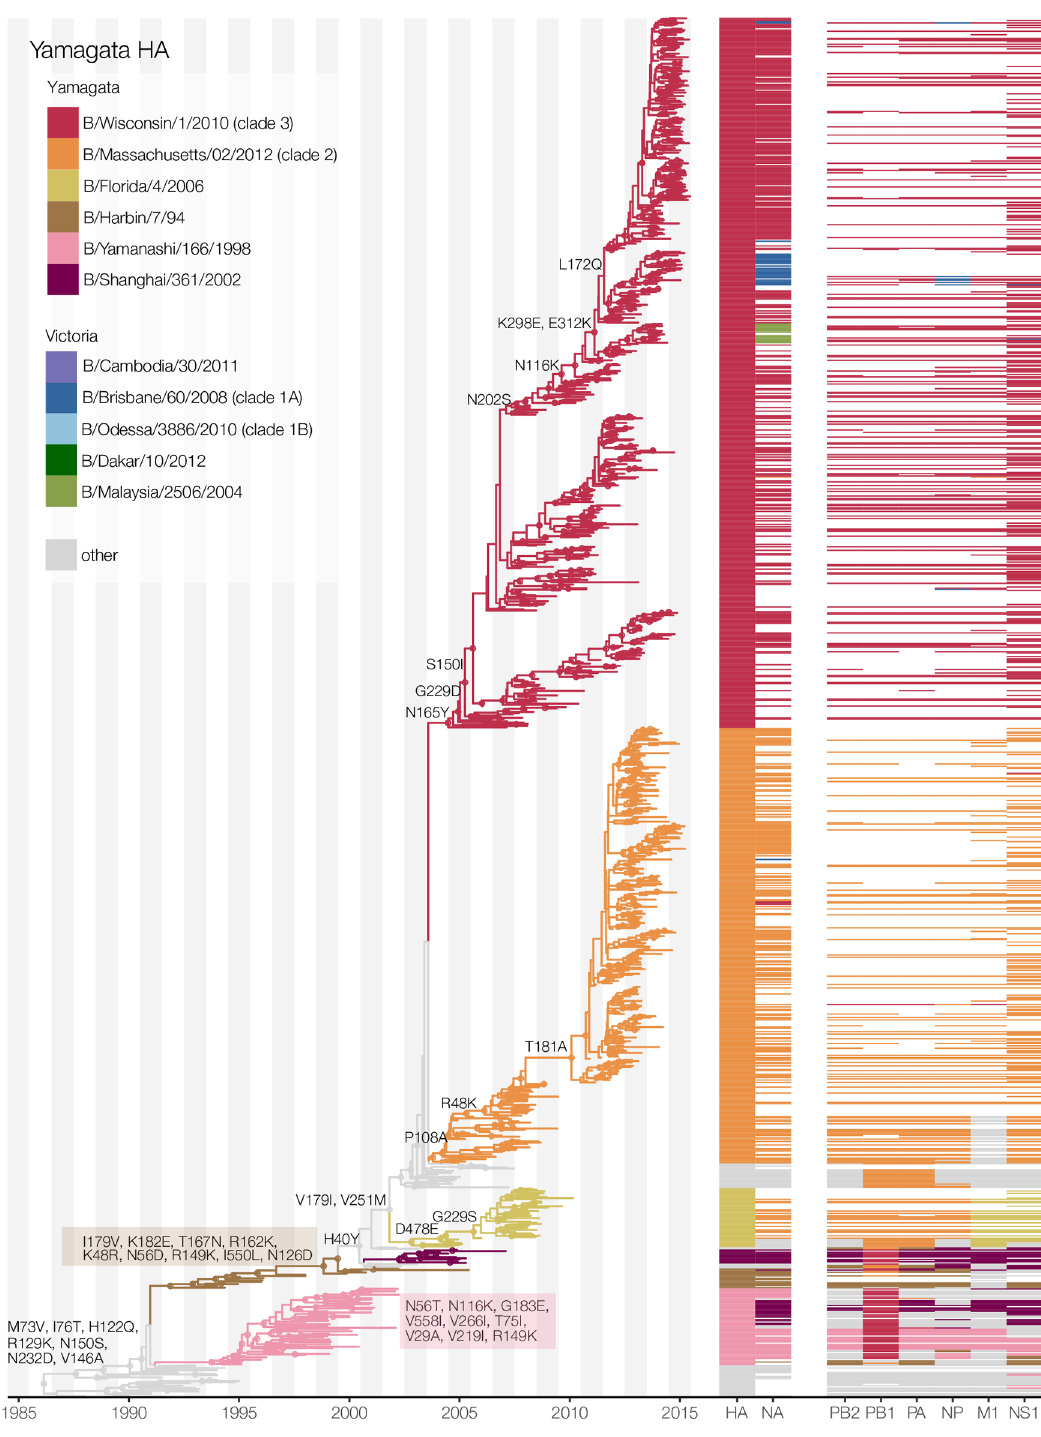
Fig 2. Maximum clade credibility tree inferred from 1,169 Yamagata-lineage HA gene sequences and corresponding genotype constellations. Branches of the phylogeny are labeled with amino acid substitutions occurring along the phylogenetic ‘trunk’ and colored by well-supported clade distinction (see legend). Clade classifications of each gene are similarly indicated by colored bars. White bars indicate that no sequence was available for that gene. Nodes with greater than 0.70 posterior probability support are shown with circle node